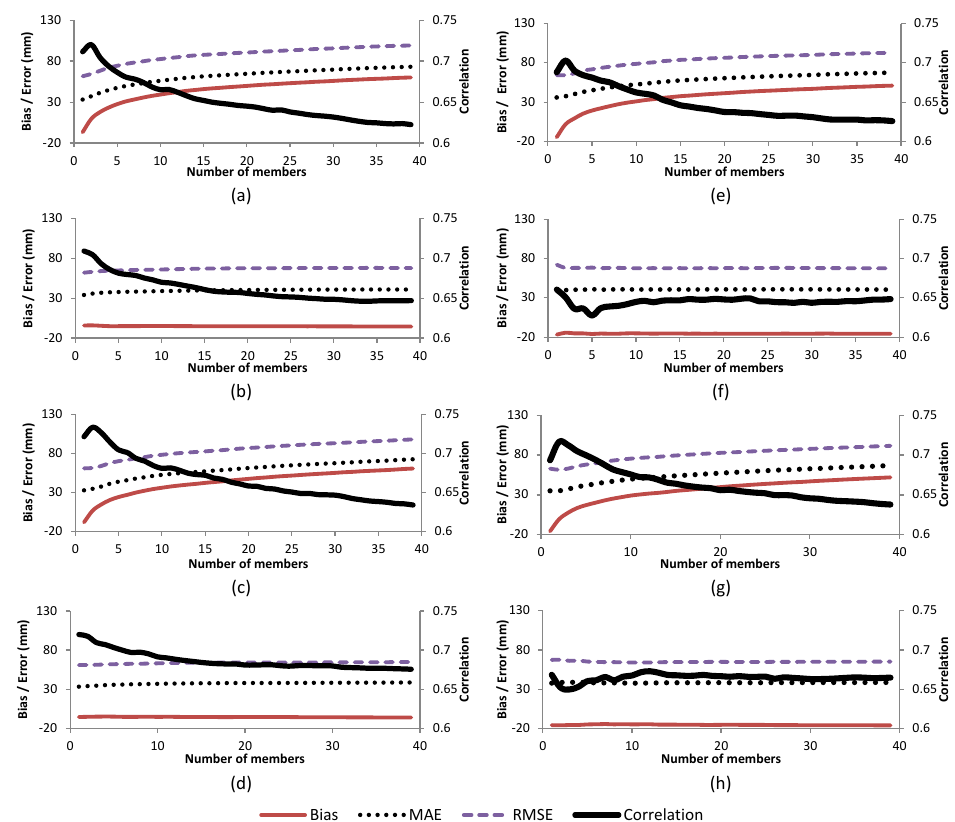
Figure 7. Correlation vs. analog TC members using GSMaP (left) and GPM (right) including bias, MAE, and RMSE of ( a , b ) all training TC, ( c , d ) all training TC with TC category adjustment, ( e , f ) with seasonality adjustment, and ( g , h ) with TC category and seasonality